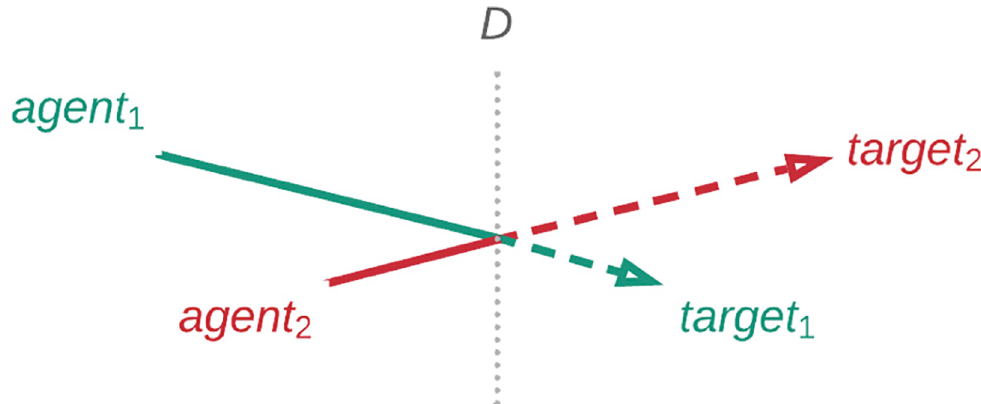
Fig 1. Schematic diagram of ideological disagreement. Segmenting disagreement at the left-right divide reveals two distinct components: agent extremity (solid section) and target extremity (dashed section).